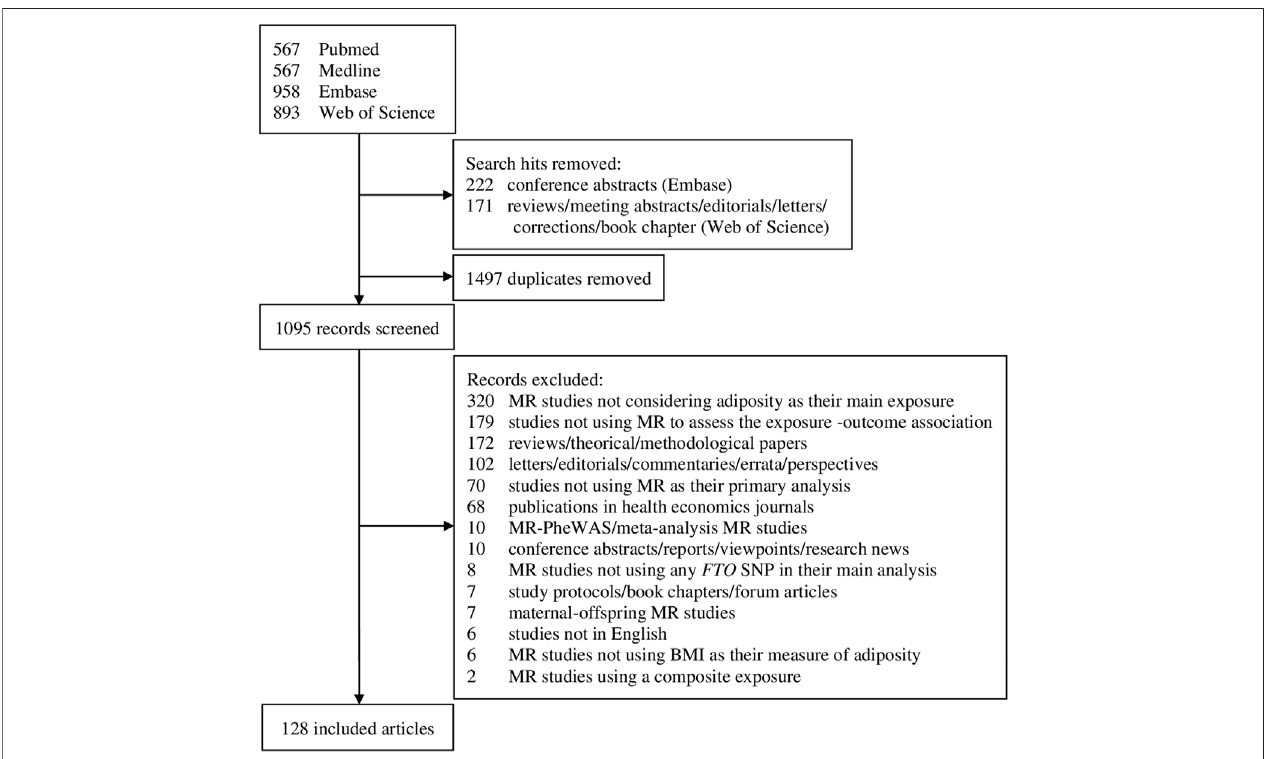
FIGURE1| Flowchartofselectionofstudiesincludesinthereview.MR,Mendelianrandomization;PheWAS, phenome-wideassociationstudy; FTO ,fatmassand obesity-associated; SNP, single - nucleotide polymorphism; BMI, body mass index.